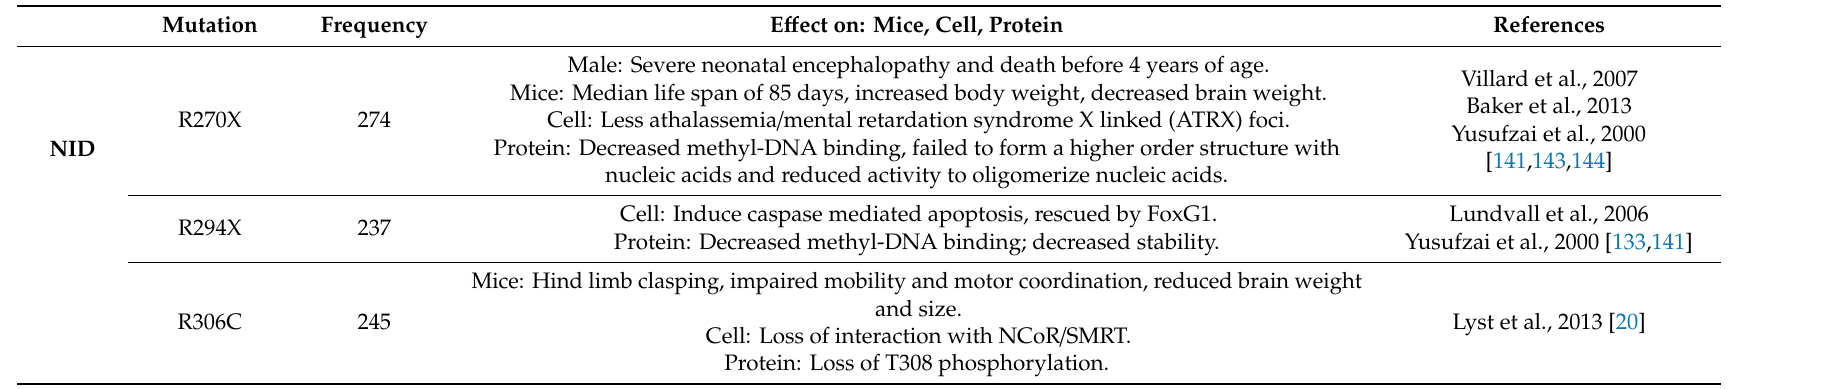
Mutation Frequency E ff ect on: Mice, Cell, Protein Male: Severe neonatal encephalopathy and death before 4 years of age. Mice: Median life span of 85 days, increased body weight, decreased brain weight. Cell: Less athalassemia / mental retardation syndrome X linked (ATRX) foci. Protein: Decreased methyl-DNA binding, failed to form a higher order structure with nucleic acids and reduced activity to oligomerize nucleic acids. Cell: Induce caspase mediated apoptosis, rescued by FoxG1. Protein: Decreased methyl-DNA binding; decreased stability. Mice: Hind limb clasping, impaired mobility and motor coordination, reduced brain weight and size. Cell: Loss of interaction with NCoR / SMRT. Protein: Loss of T308